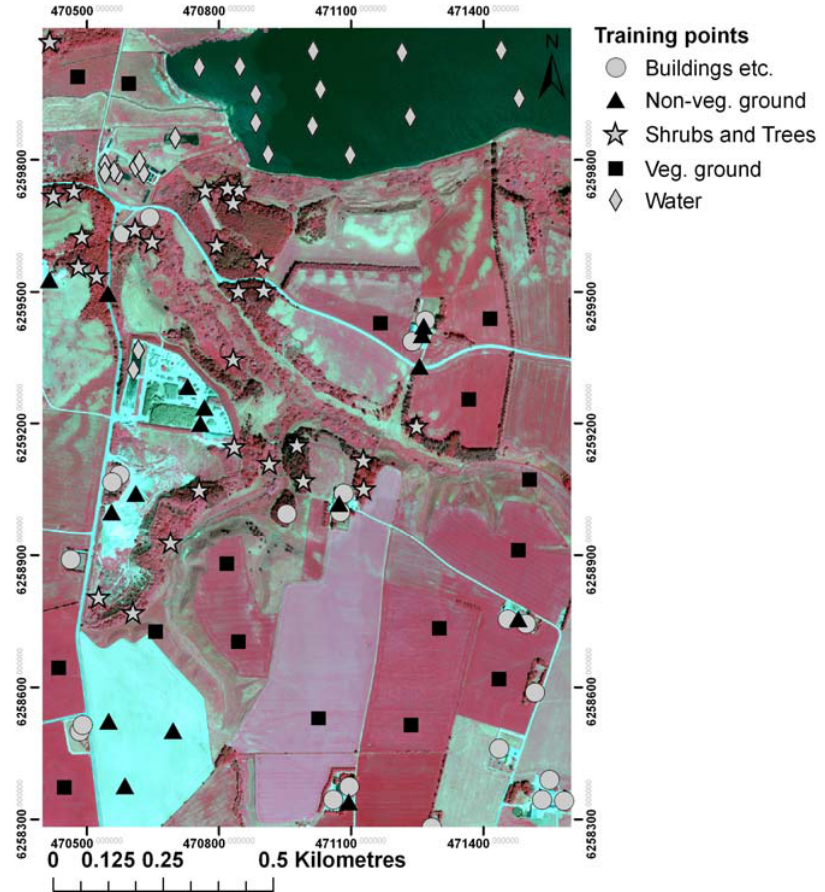
Figure 7. Tile 4 and the location of points used for selecting training data (segments) applied as input for the CART analysis. For the CART analysis related to the classification based on the nDSM and the CIR orthoimages, only the elevated training data were used (shrubs and trees and buildings), whereas all training data were applied in the CART analysis related to the classification based only on the CIR